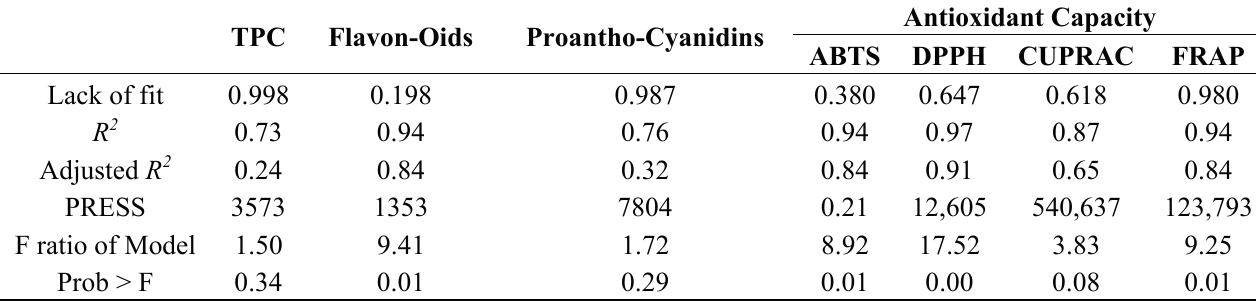
Table 2. Analysis of variance for the determination of model